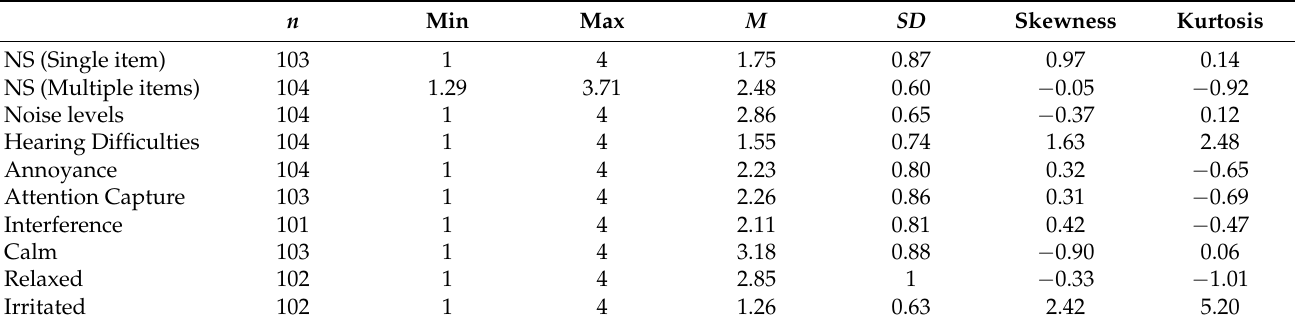
Table 1. Descriptive statistics for all the variables used in Study